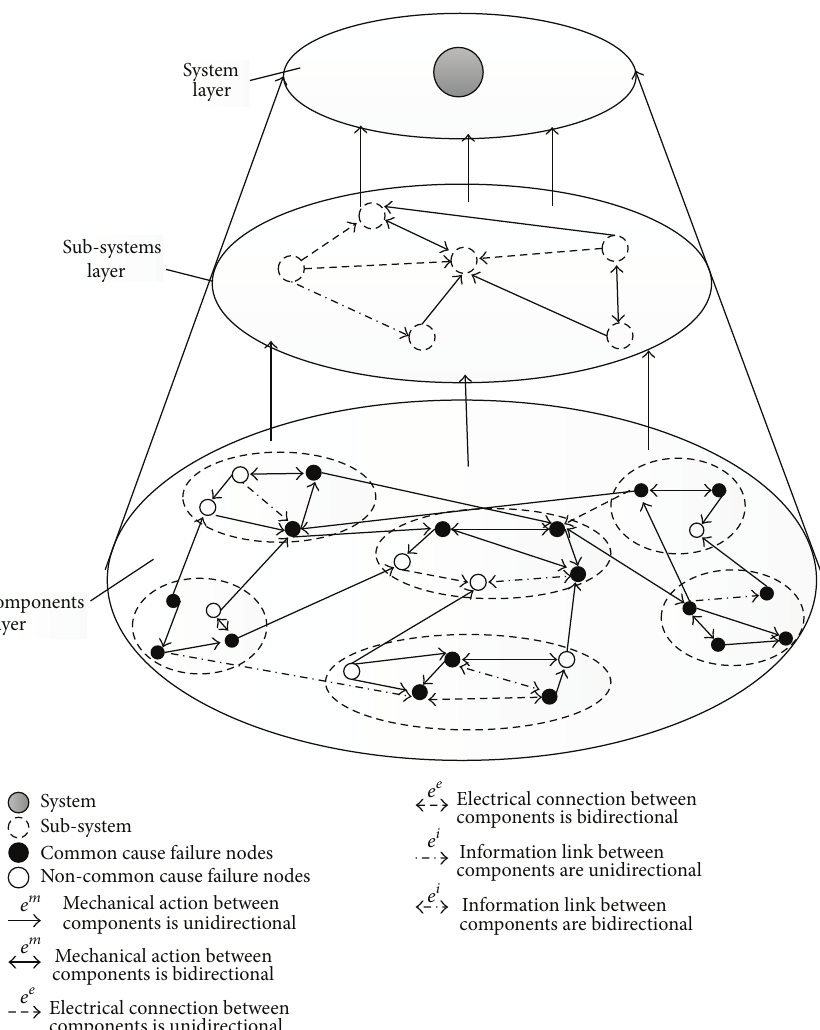
Figure 1: System reliability